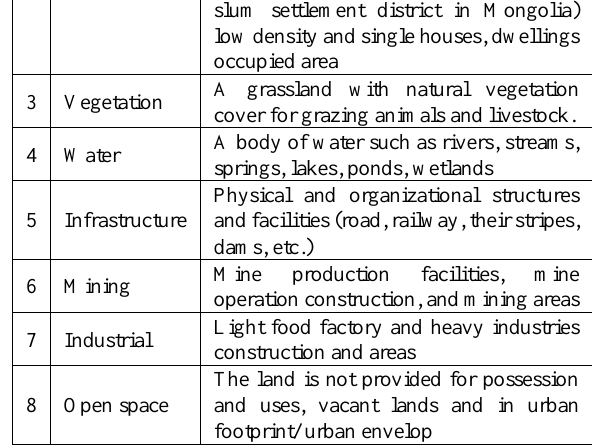
Table 2. Classified images of Land